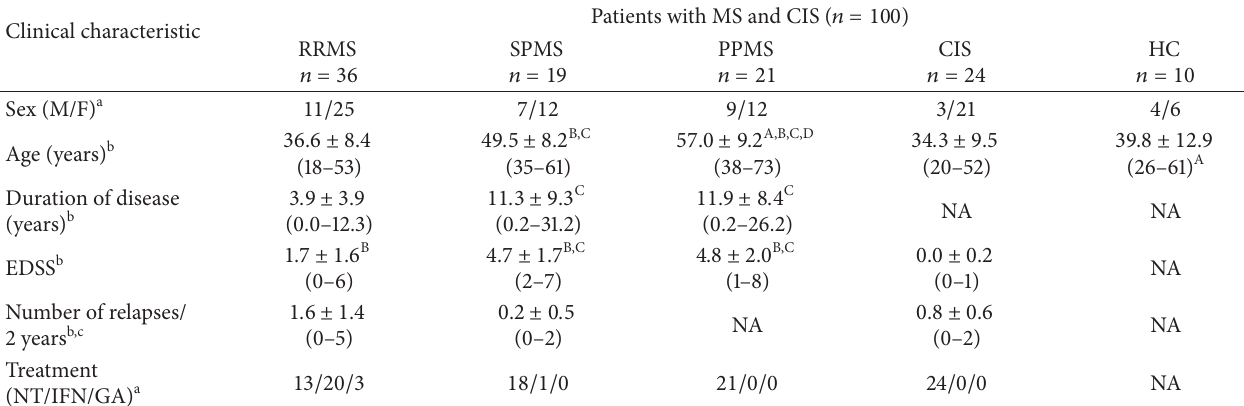
Table 1: Clinical characteristics of patients with different subtypes of multiple sclerosis, clinically isolated syndrome, and controls. Clinical